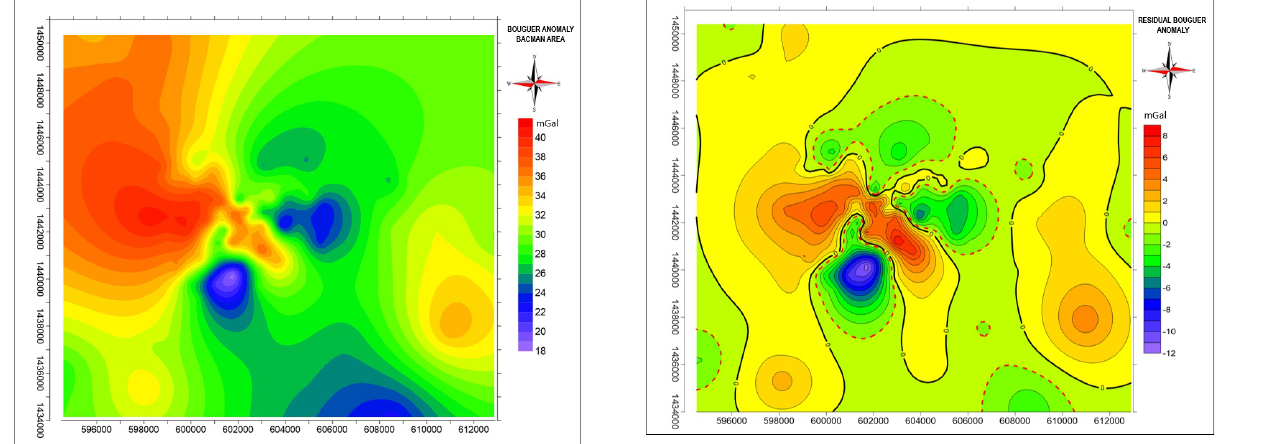
Fig. 6. Map of the Bouguer anomaly of the Bac-Man geothermal field area